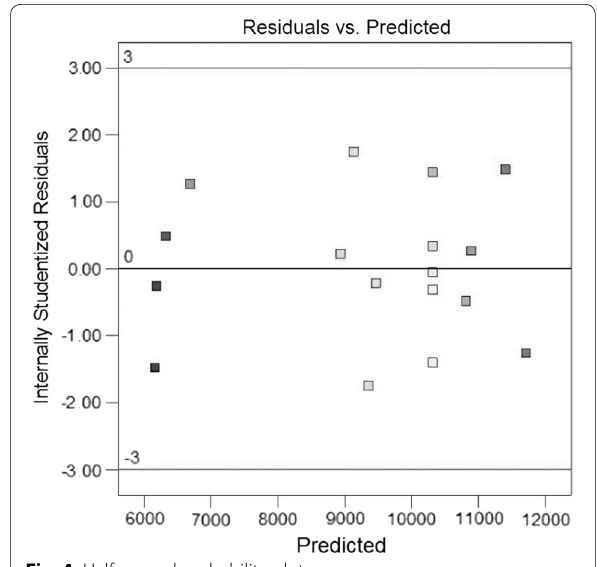
Fig. 4 Half‑normal probability